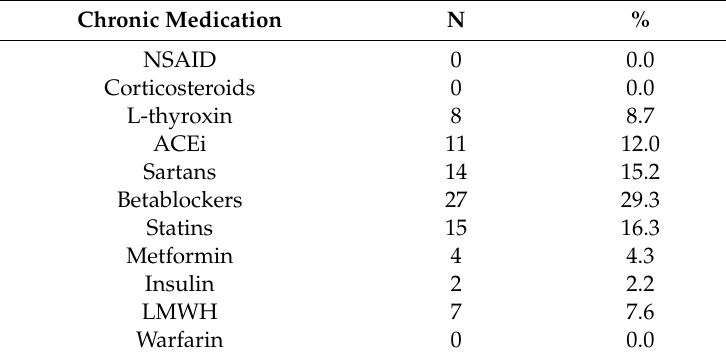
Table A1. Drug history in the last 6